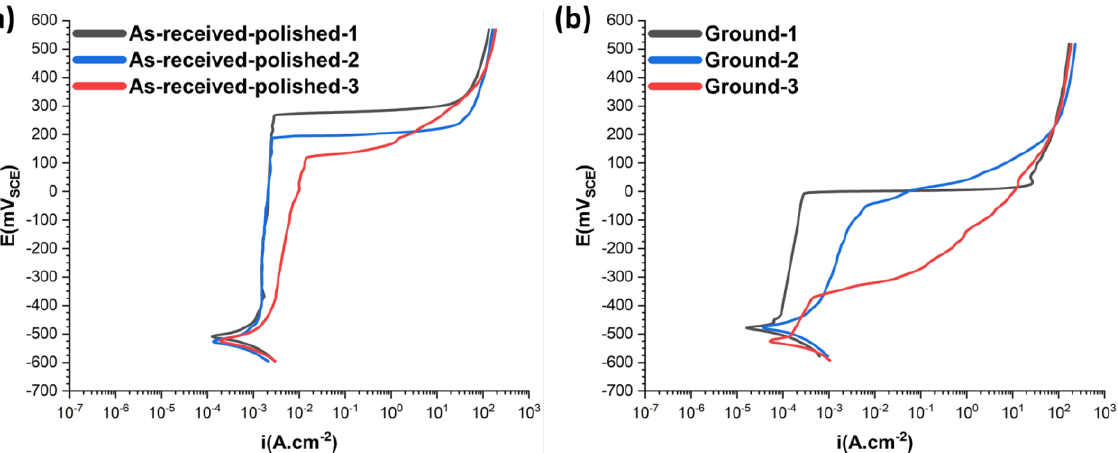
Figure 4. Potentiodynamic polarization results in specimens with various energy input densities, for ( a ) as-received polished and ( b ) ground state. ( a ) as-received polished and ( b ) ground